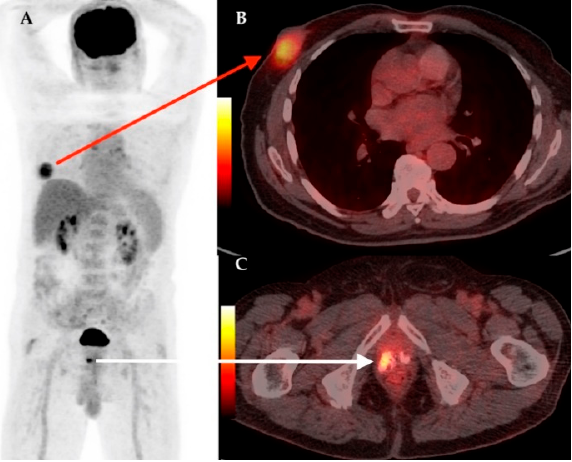
Figure 4. Male patient with right breast cancer. Synchronous confirmed prostate adenocarcinoma. MIP image on F18-FDG PET/CT ( A ); axial section at thorax level showing right breast lesion with increased F18-FDG uptake confirmed breast carcinoma on biopsy ( B , red arrow); axial section at pelvic level showing pathologic increased F18-FDG uptake in right prostate lobe area with multiple calcification ( C , white arrow), confirmed prostate adenocarcinoma.